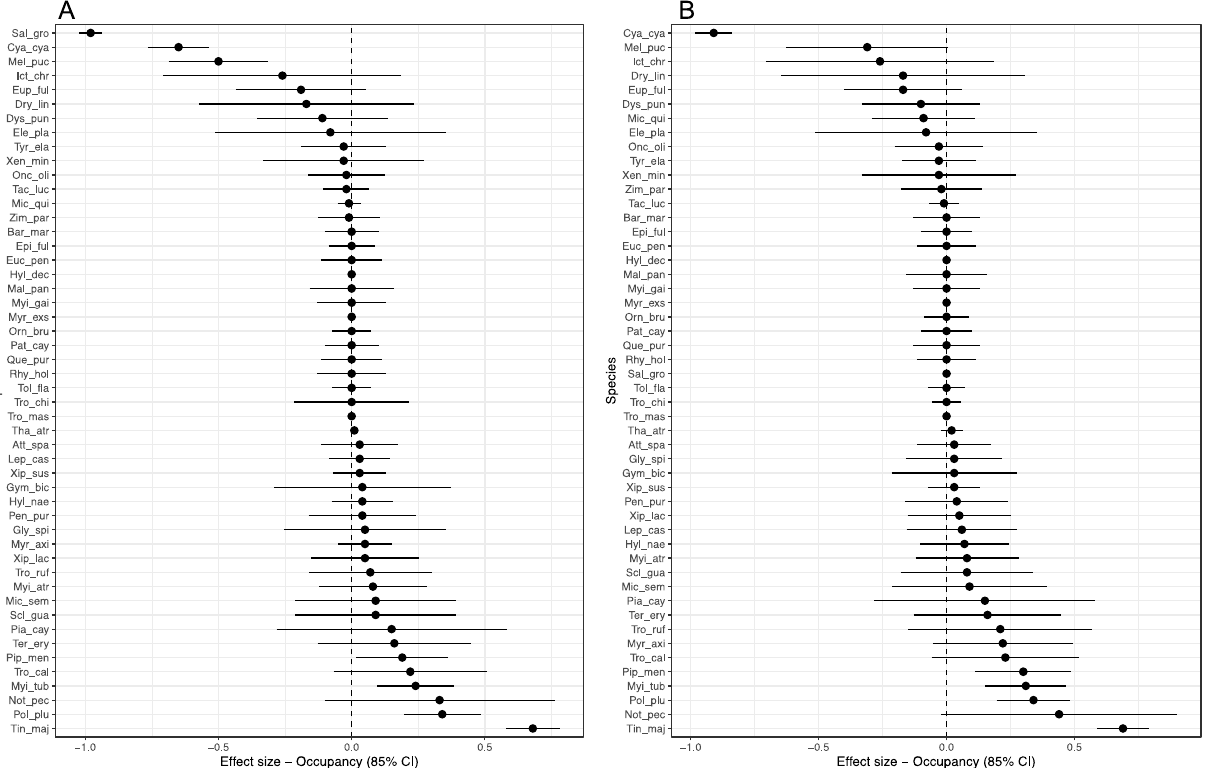
Figure 3. Model-averaged estimates of effect sizes of Era on bird occupancy in ( A ) old-growth forest and ( B ) secondary forest. Error bars are 85% confidence intervals. The dot line represents no change in occupancy between Eras; species to the left of the line had higher occupancy in the historical era, whereas species to the right of the line had higher occupancy in the current era. For more information on species code and names, see Table S1.